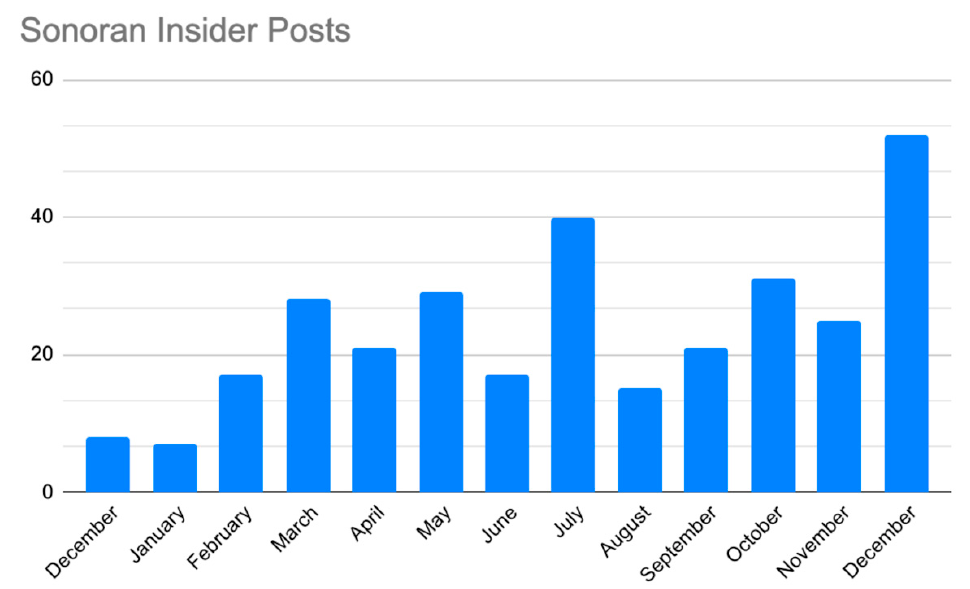
Figure 2. Number of posts on Instagram with the hashtag #sonoraninsiders by month, from Decem-